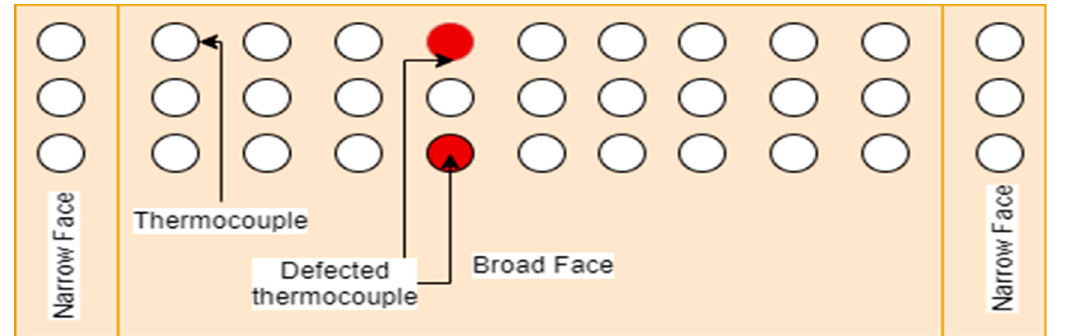
Figure 7. Mold replacement recommended.